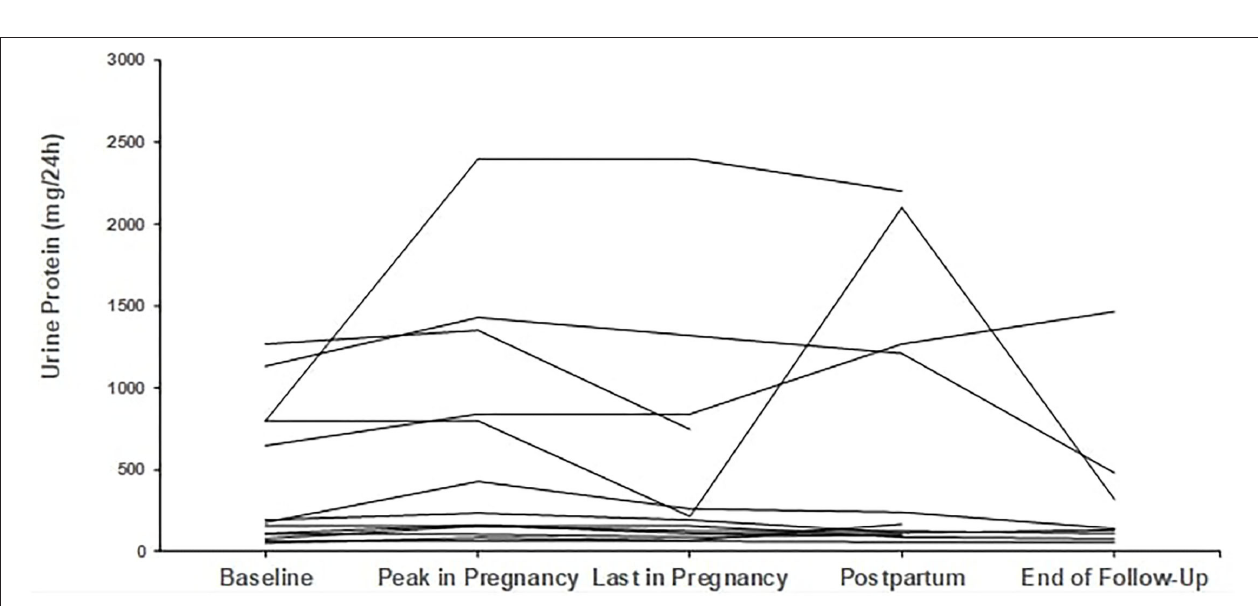
FIGURE 4 | Trends in proteinuria in patients with secondary glomerular diseases ( n = 9). Individual trends in proteinuria at five time points: baseline, peak during pregnancy, last pregnancy visit, postpartum, and end